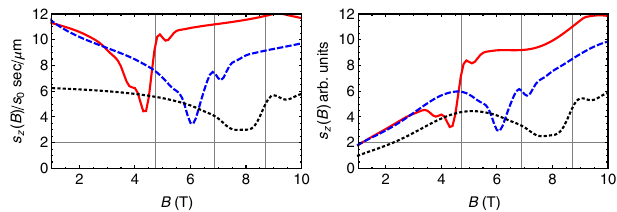
FIG. 5. The stationary spin polarization s as a function of z the magnetic field B for (a) parabolic and (b) square-well lateral confinement. In all computations, α − ¼ 2 × 10 − 13 eV m, and the width of the injection aperture is 0 . 5 μ m. The effective mass is m ¼ 0 . 067 m , and the g factor is − 0 . 44 . The distance e from the source, x − x , is 20 μ m in (a) and (b). For s square-well confinement, the width of the well W in (b) and (d) is 1 . 15 μ m The inset in (b) shows s versus B when W ¼ 3 μ m and x ¼ 6 . 7 μ m, as in Ref. [26]. Except for the inset, the number of propagating modes (including spin) in all panels is 40. In the inset there are 105 propagating modes. Panels (c) and (d) show the dependence of the spin polarization on distance from the source for the parabolic and square-well lateral confine- ment, respectively. B ¼ 3 T (solid red line), B ¼ 6 T (dashed blue line), and B ¼ 7 T (dotted black line). The parameters used for parabolic confinement are μ ¼ 3 . 65 meV, ℏ ω ¼ 0 . 1785 meV, so that the magnetic field at the minimum is 7.0 T. FIG. 6. Spin polarization for three Fermi velocities: solid red For square-well confinement, μ ¼ 1 . 86 meV, whereas in the 0 . 7 × 10 5 cm = s;dashedblue line, v 1 . 0 × 10 5 cm = s; line, v inset it is 1.765 meV. Parameters have been chosen to mimic F ¼ F ¼ 1 . 3 × 10 5 cm = s. Channel width is 1 . 2 μ m. dotted black line, v those of Ref. F ¼